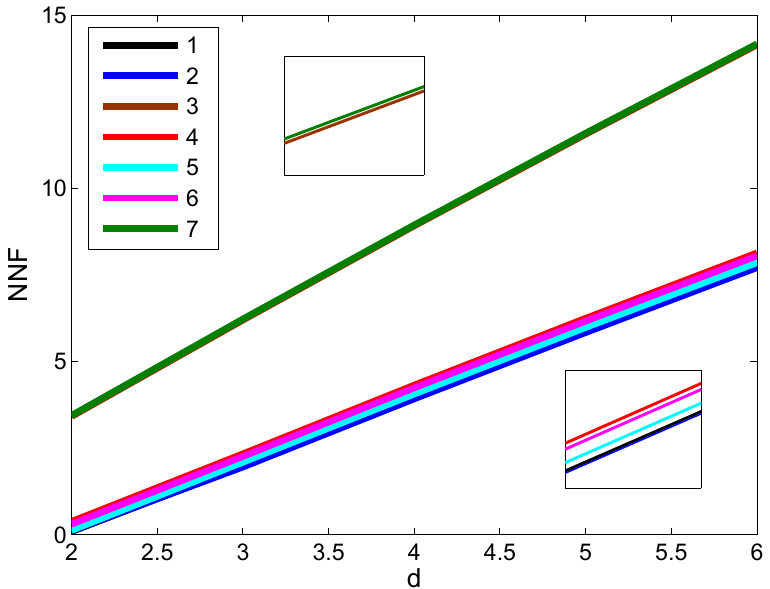
Figure 5. Plots of NNF as function of d for the models without the hematocrit: 1—Cross model with parameters from [9]; 2—Cross model with parameters from [16]; 3—Simplified Cross model; 4—Modified Cross model; 5—Carreau–Yasuda model; 6—Carreau model; 7—Yeleswarapu model.